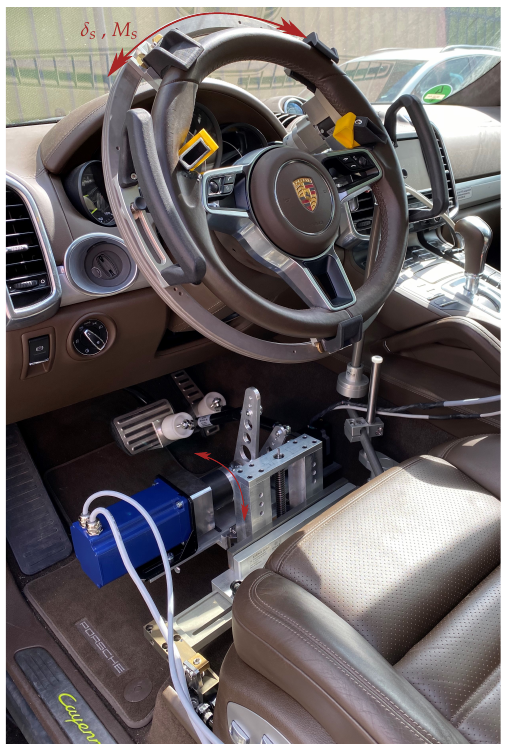
Figure 5. Driving robot consisting of a steering and pedal robot used at the test bench in a